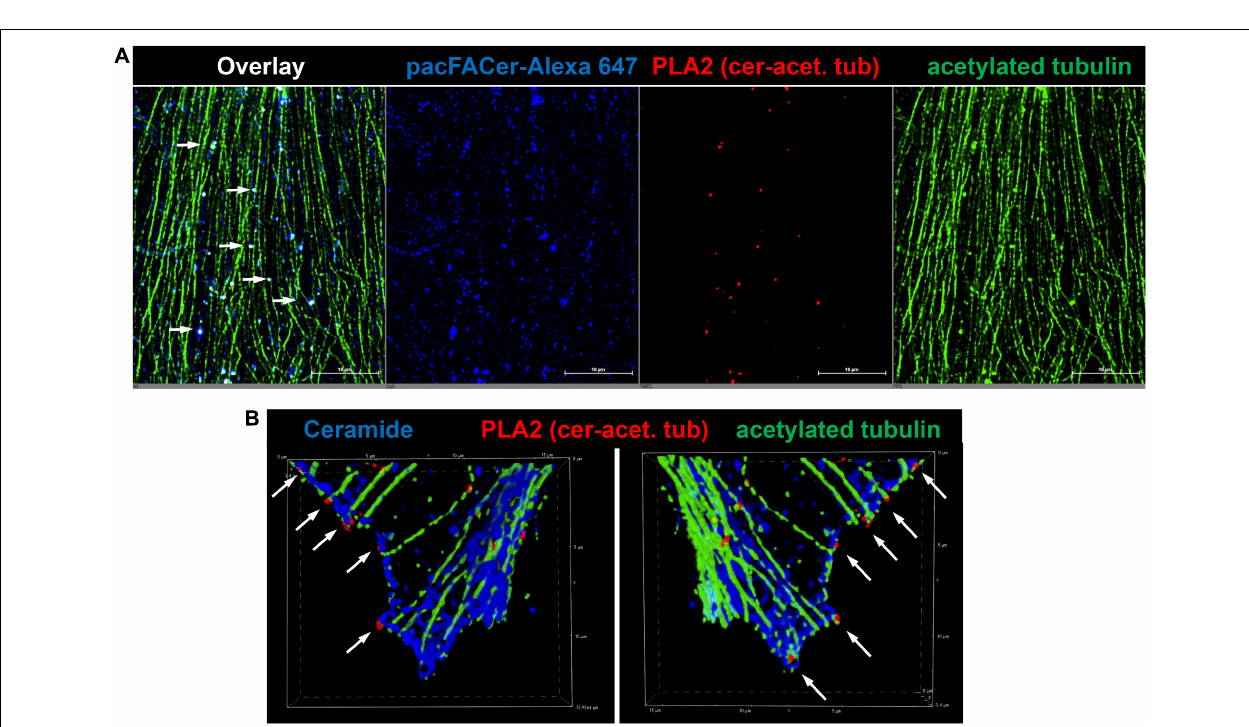
FIGURE 4 | PLA2 reaction using antibodies against acetylated tubulin and ceramide. (A) Primary cultured astrocytes were subjected to the PLA2 reaction (fluorescence signals for complexes of acetylated tubulin with ceramide are pseudo-colored in red) and then post-incubated with Alexa Fluor 488-conjugated secondary antibody to visualize microtubules (pseudo-colored in green). Cross-linked pacFACer (conjugated to Alexa Fluor 647) is pseudo-colored in blue. (B) PLA2 reaction performed as in (A) , but pacFACer not conjugated to Alexa Fluor 647. The PLA2 reaction was post-incubated with Alexa Fluor 488-conjugated anti mouse IgG to visualize acetylated tubulin (pseudo-colored in green) and Alexa Fluor 647-conjugated anti-rabbit IgG to visualize ceramide (pseudo-colored in blue).